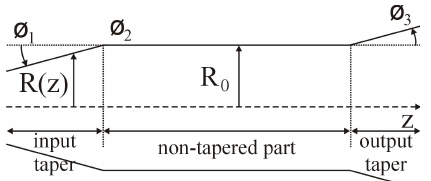
Figure 1. Resonator wall profile along z